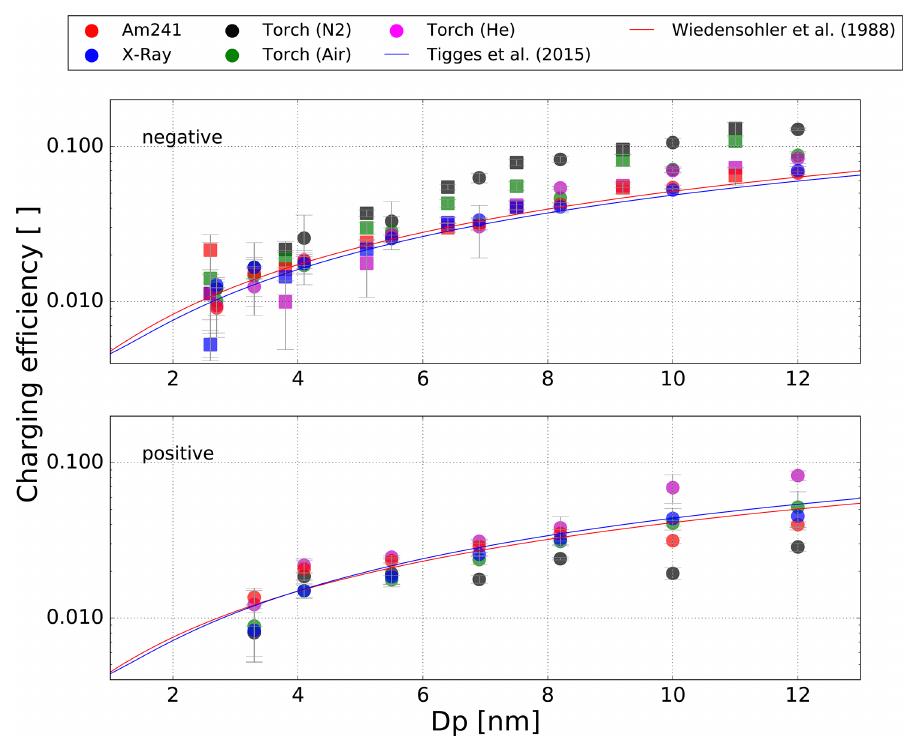
Figure 6. Measured charging efficiencies for the different aerosol chargers for negatively and positively charged Ag particles (dots) and negatively charged NaCl particles (squares) with mobility diameters less than